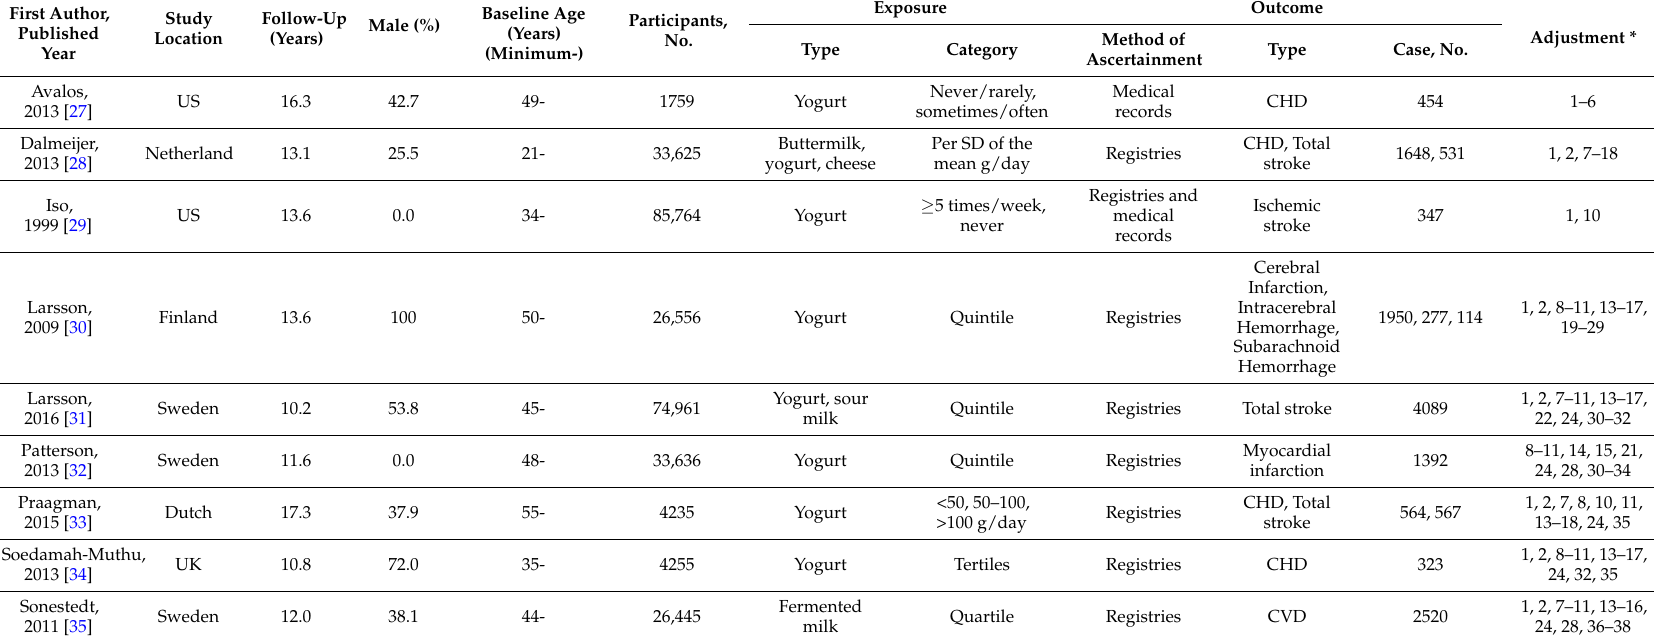
Table 1. Characteristics of the included